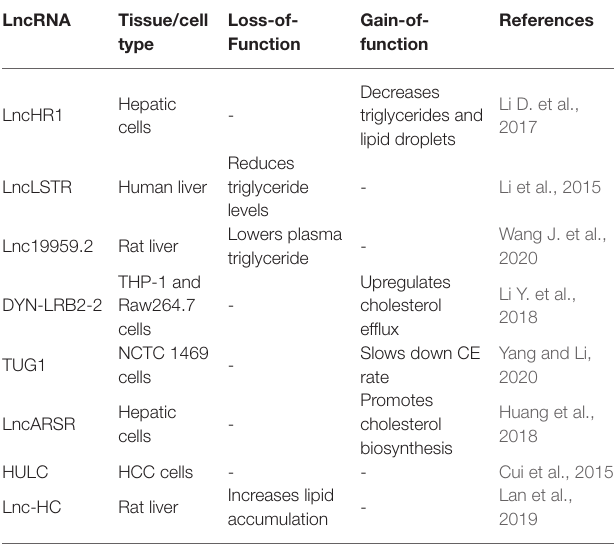
TABLE 4 | Key roles of LncRNAs in regulating lipid homeostasis in the liver.